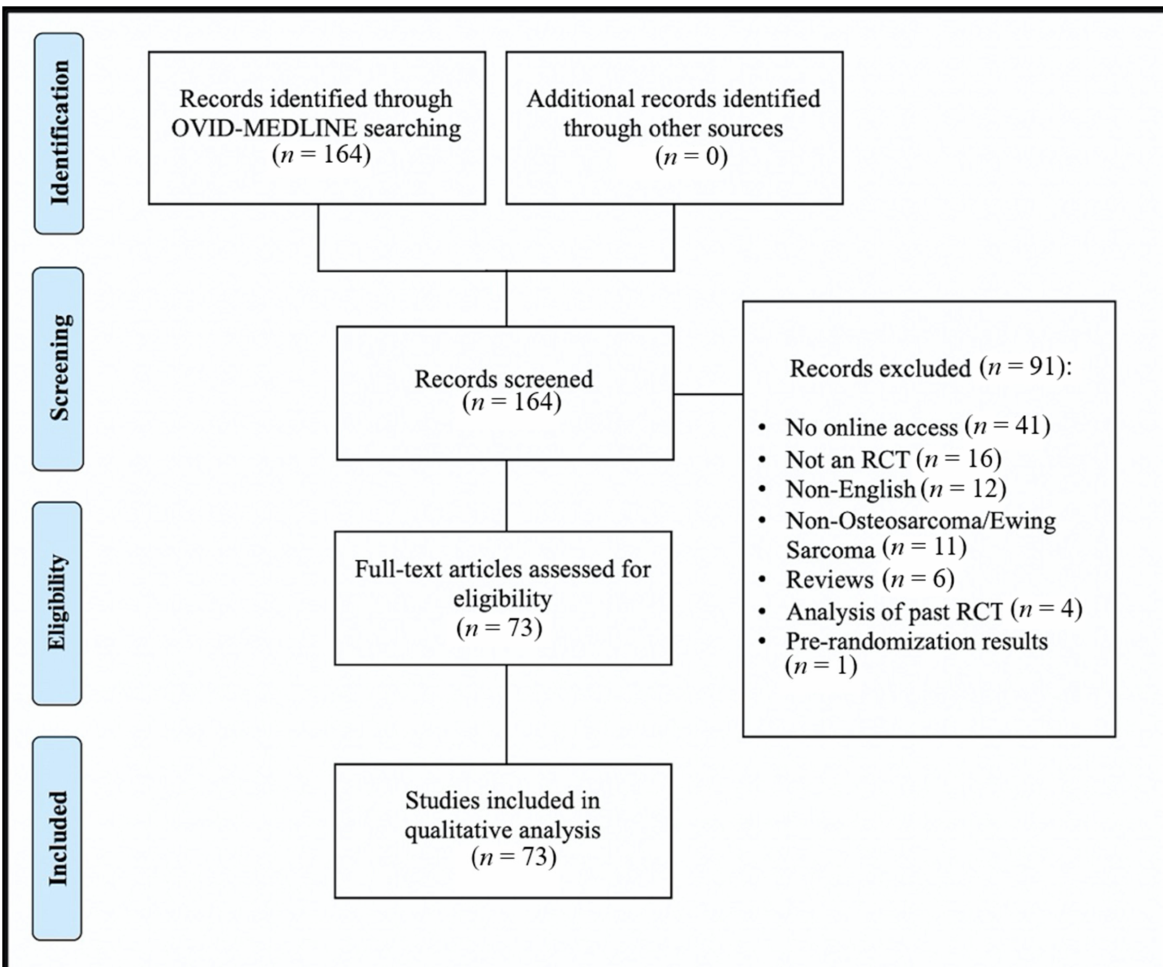
Figure 1. Flow diagram of included/excluded